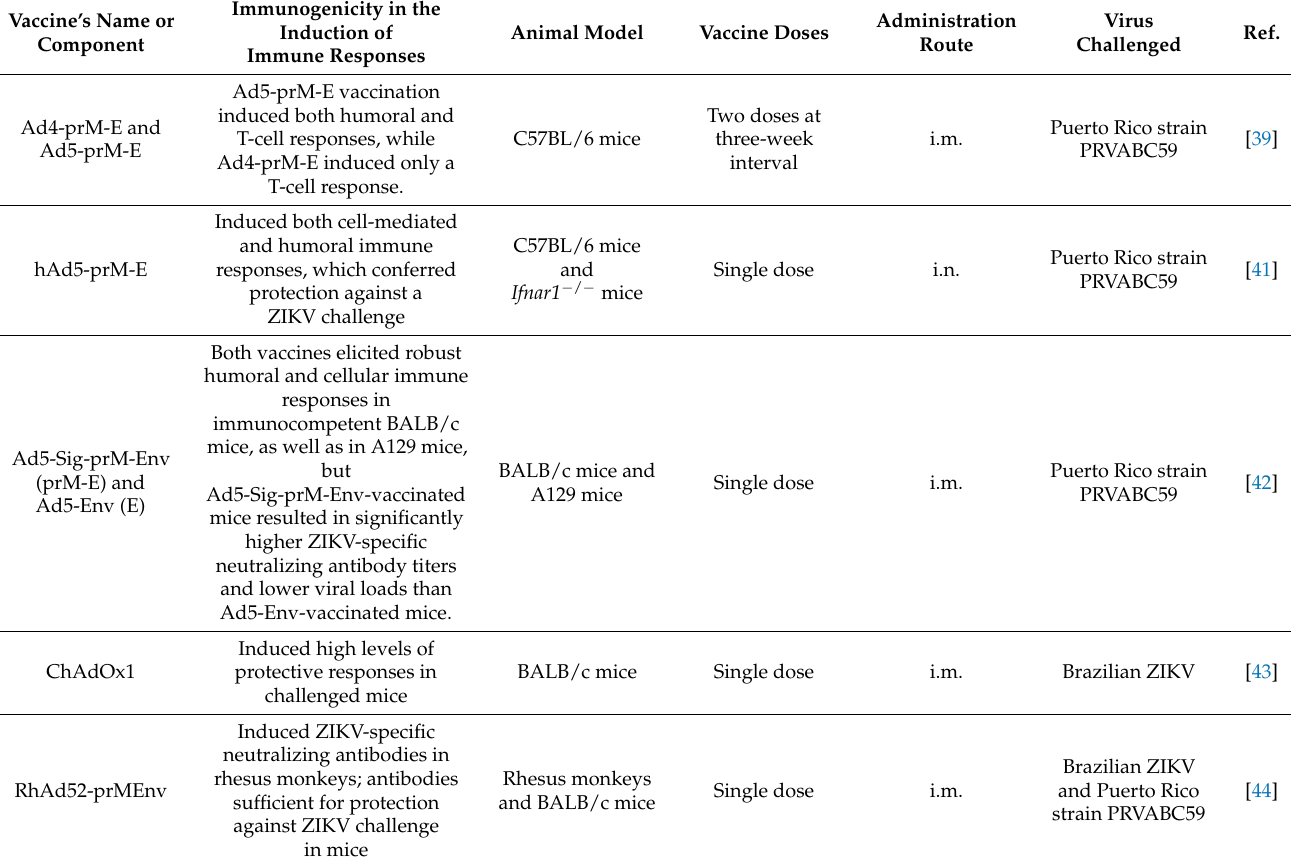
Table 4. Virus-vector-based vaccines against ZIKV